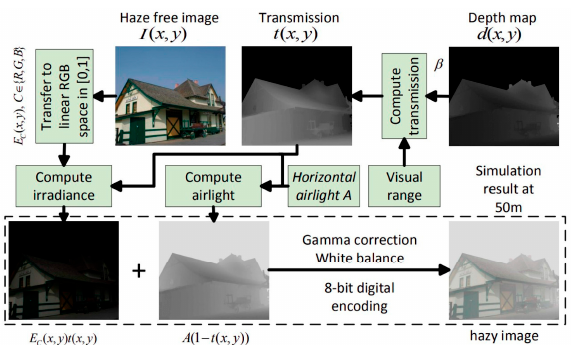
Figure 7. Description of Zhang [19] method for generating the database used in the Figure